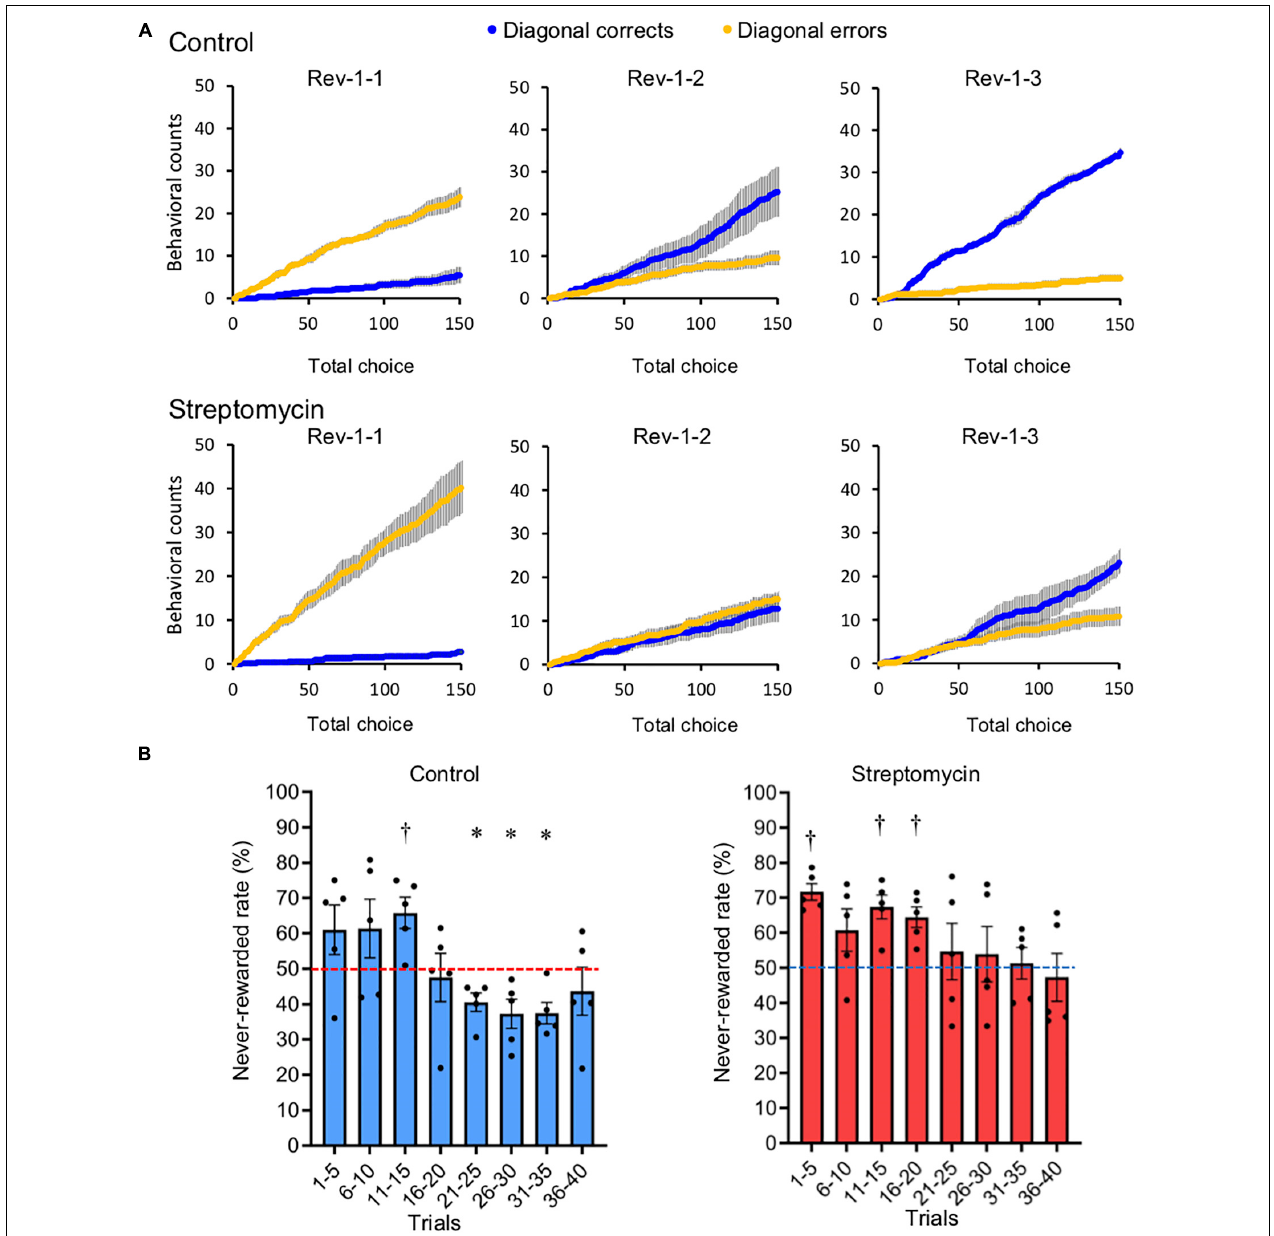
FIGURE 4 | Comparison of adaptation speed to the reversed contingency. (A) Cumulative diagonal correct (blue) and error (yellow) counts (described in Figure 1F ) within the first 150 choices in each of the first three sessions of Rev-1 (Rev-1-1 to Rev-1-3) ( n = 5/group). (B) Never-rewarded rates in every 5-trial block of the first 40 trials, which all mice completed, in the first session of Rev-1 (Rev-1-1). ∗ , † p < 0.05, significantly lower ( ∗ ) or higher ( † ) from chance level (50%) using Student’s one-sample t -test. Horizontal dotted lines represent 50% chance level. Error bar represents SEM of never-rewarded rates compiled for every five-trial block. This value did not significantly decrease below chance level in streptomycin-treated